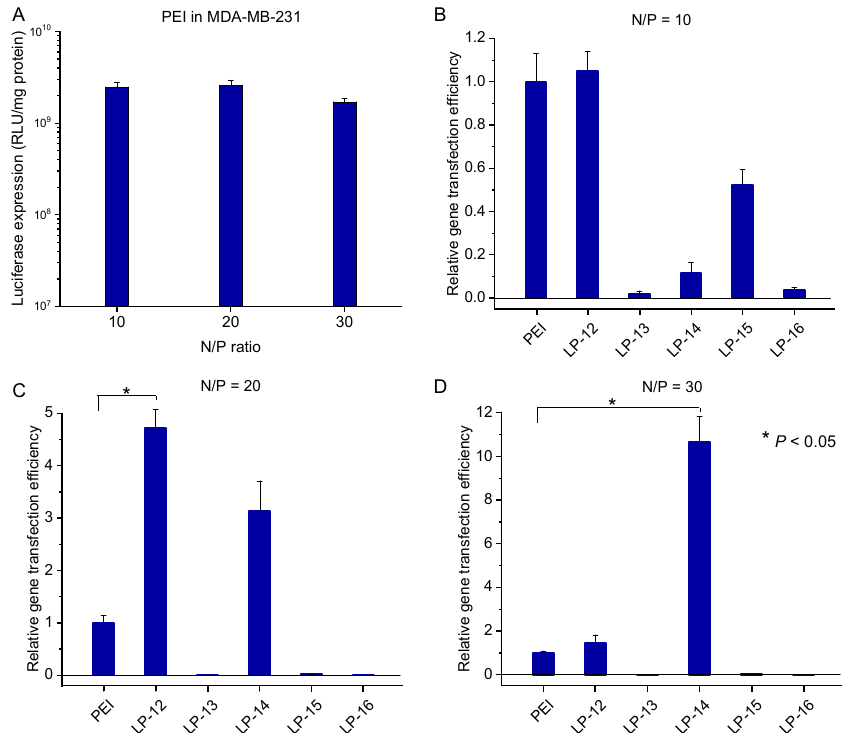
Figure 11. In vitro gene transfection efficiency of the complexes of PEI/pDNA in MDA-MB-231 cells in the presence of serum at different N/P ratios ( A ). Relative gene transfection efficiency of the complexes of LP/pDNA in MDA-MB-231 cell line in the presence of serum at N/P of 10 ( B ), 20 ( C ) and 30 ( D ). Data represent mean ± standard deviation (* p < 0.05, n = 2).